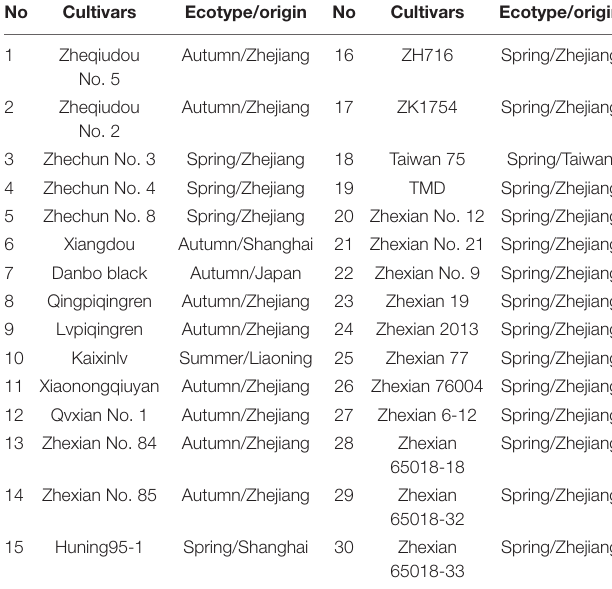
TABLE 1 | The ecotype and origin of the 30 vegetable soybean cultivars used in the present